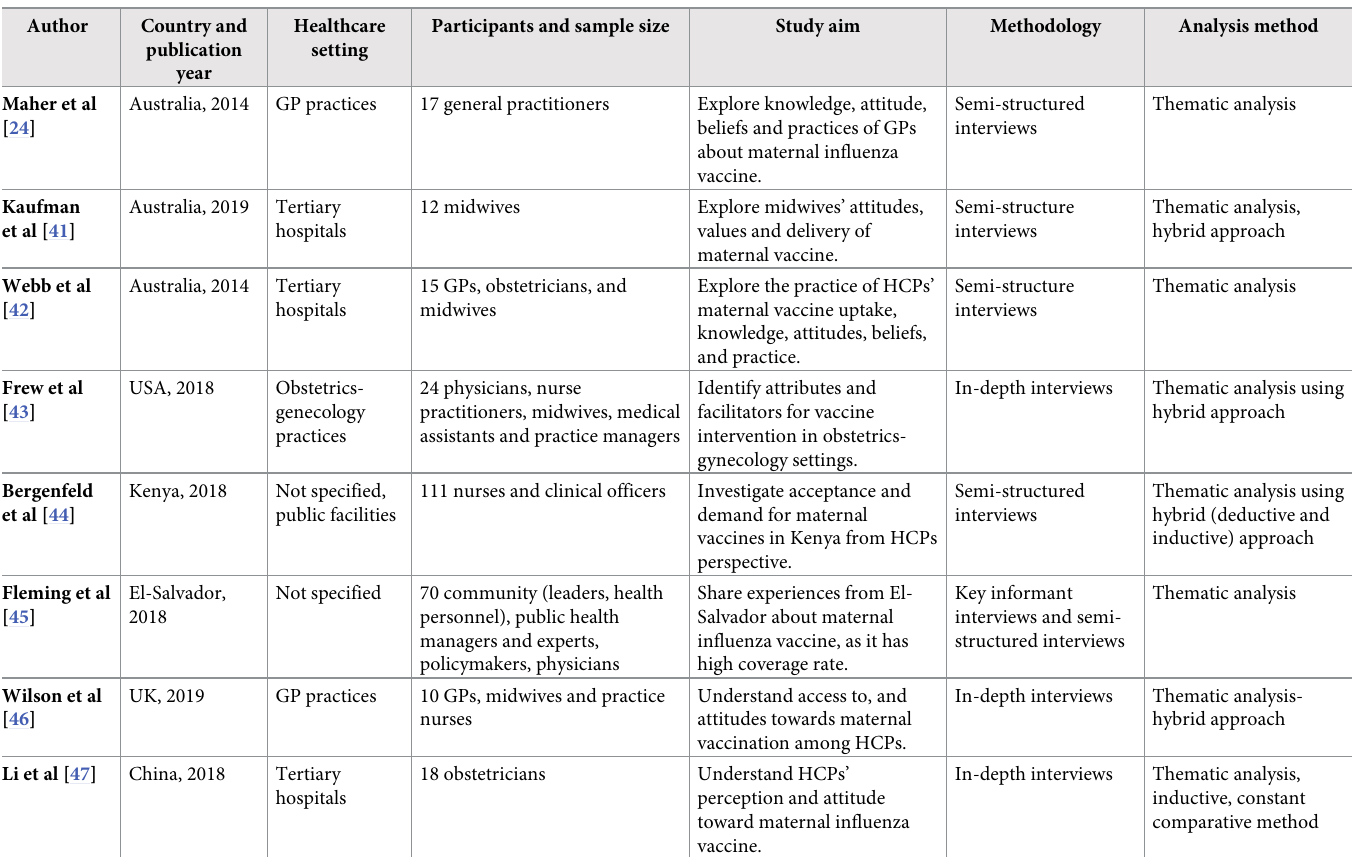
Table 2. Characteristics of studies included in the thematic